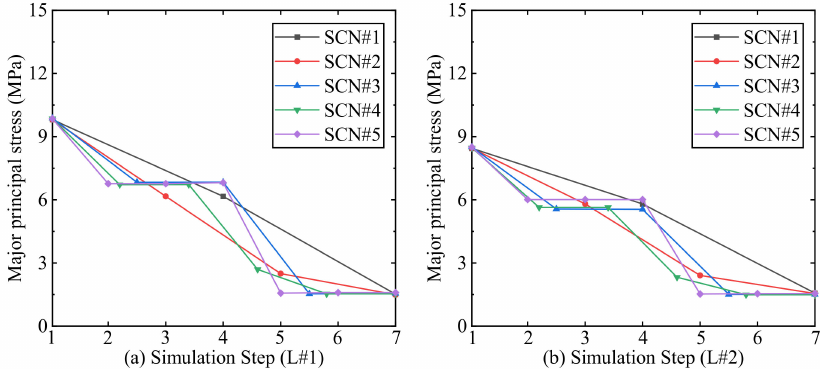
Figure 5. Major principal stress of sidewall middle of level #1 and level